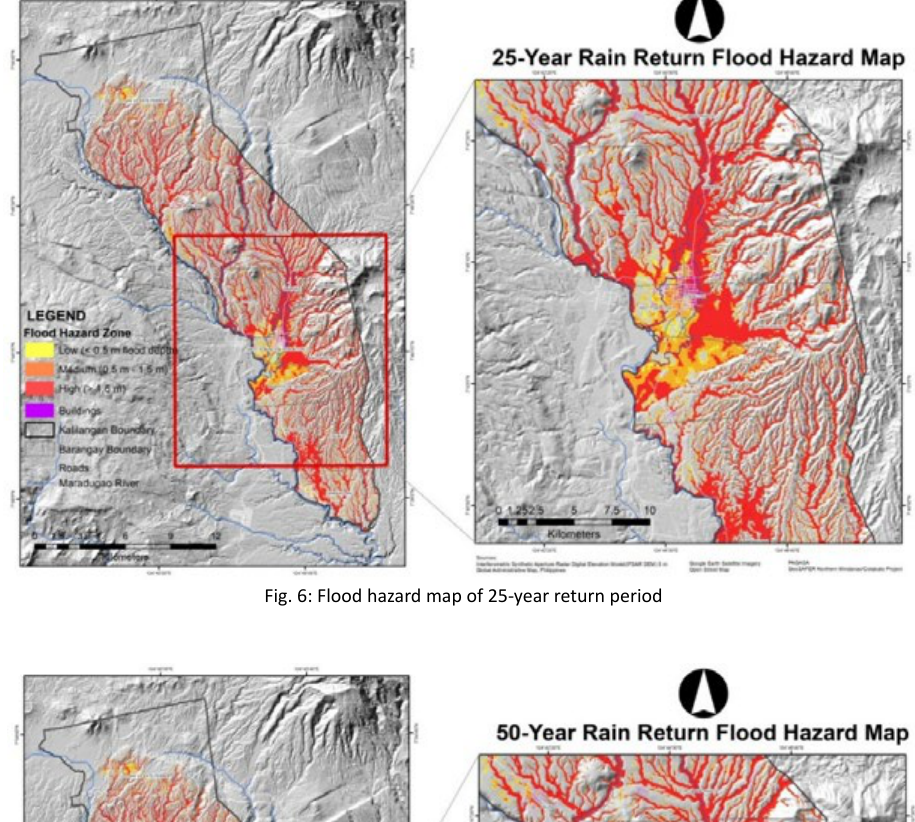
Fig. 6: Flood hazard map of 25-year return period